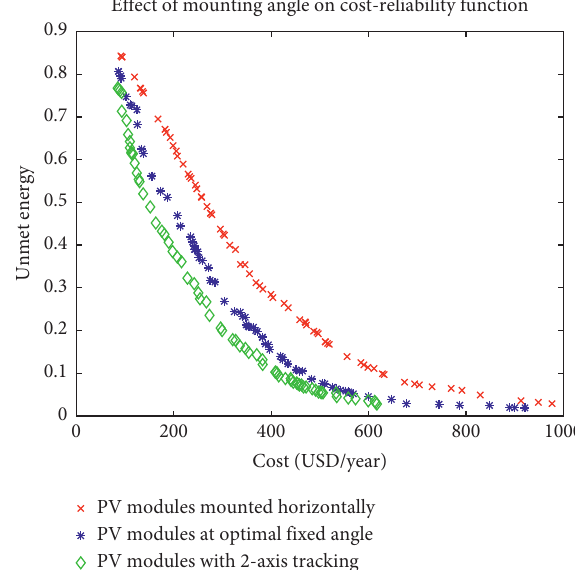
Figure 1: The cost-reliability curves of a hybrid wind/solar system for a detached house of 5 people with different tilt angles of PV panels (wind turbine hub height: 12m; battery type: Li-ion bat- teries; using measured weather data from Holt; yearly consump- tion: